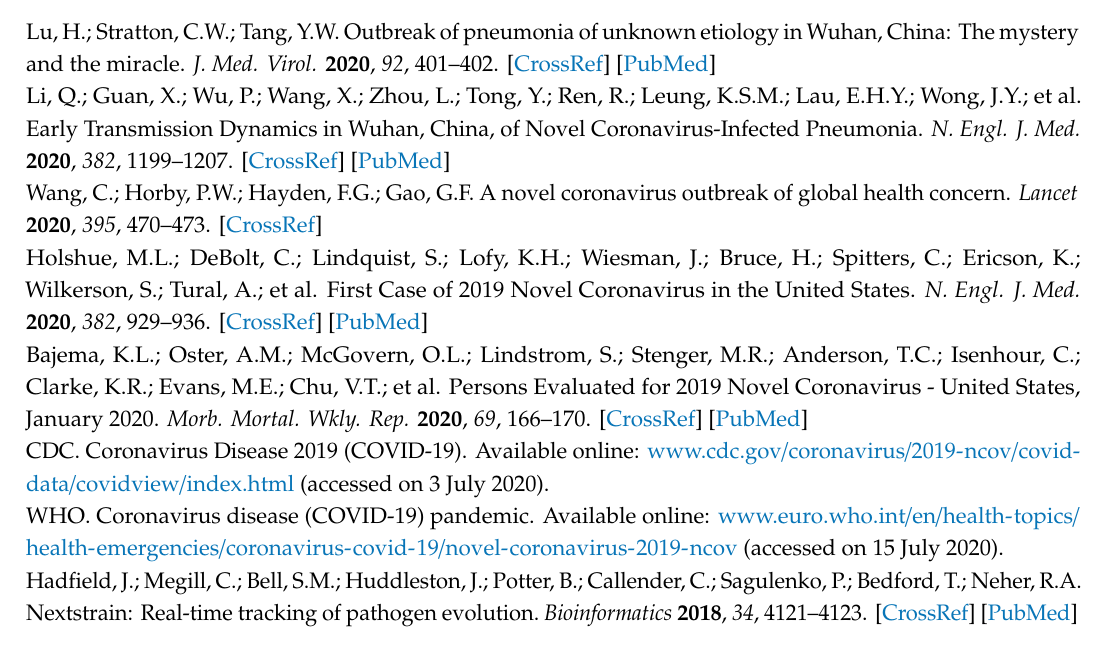
Figure S1: Whole genome-based phylogenetic tree of ICVL local outbreak and additional Israel-based samples, Table S1: Mixed-nucleotide